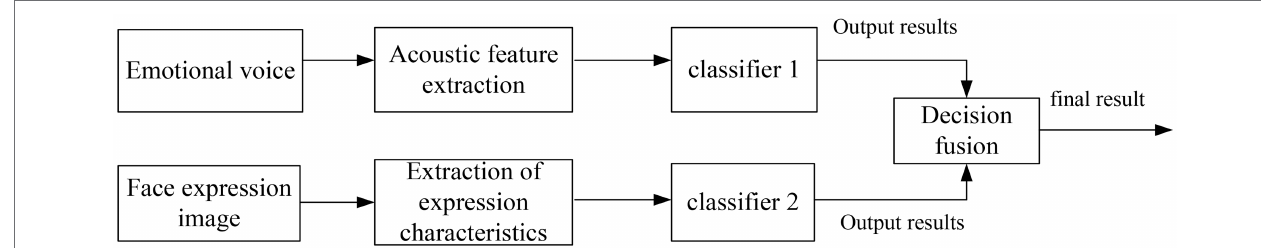
FIGURE 6 | Schematic diagram of decision-making layer fusion emotion